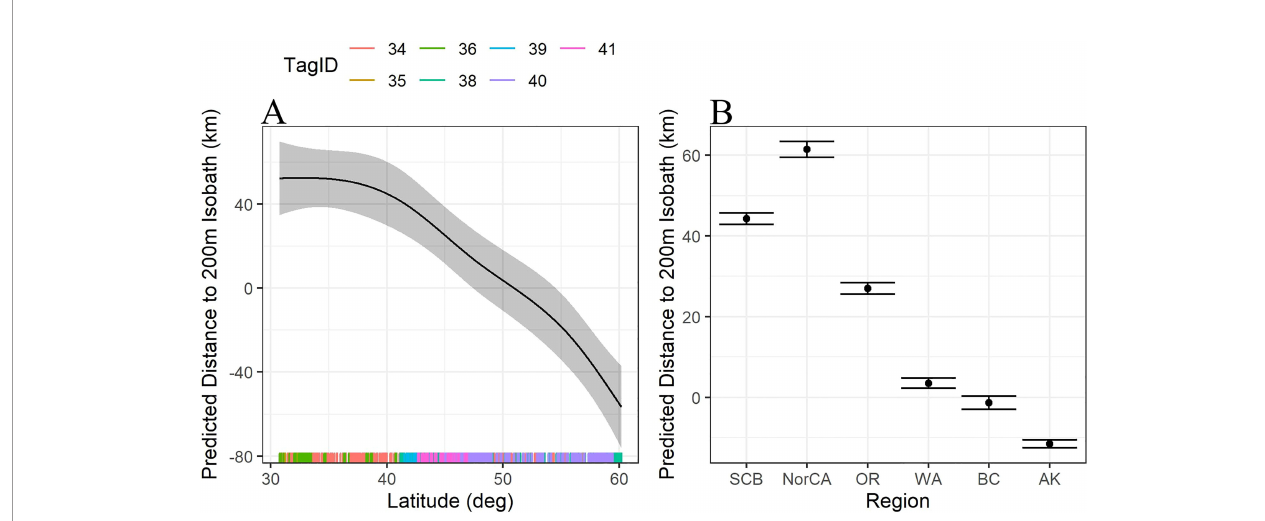
FIGURE 2 | (A) Trendline for the predicted distance to the 200m isobath (km) as a function of latitude. Distances below 0 are shallower than 200m, distances greater than 0 are deeper than 200m. (B) Predicted distance to the 200m isobath (km) as a function of region. Habitat use south of WA are much further offshore, habitat use north of WA is generally up on the shelf edge, inside the 200m isobath. SCB=Southern California Bight including all locations south of Pt Conception (n=476); NorCA = Northern California, including all latitudes north of Pt Conception to Oregon State boundary (n=188); OR, Oregon (n=377); WA, Washington (n=447); BC, British Columbia (n=253); AK, Alaska